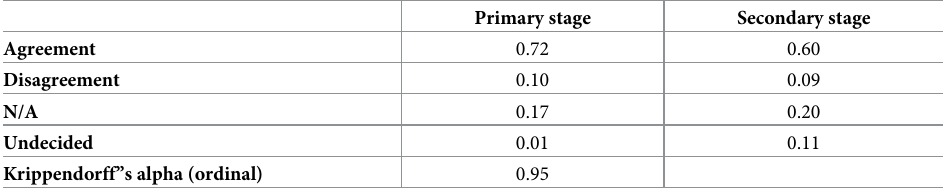
Table 3. Interrater agreement metrics a